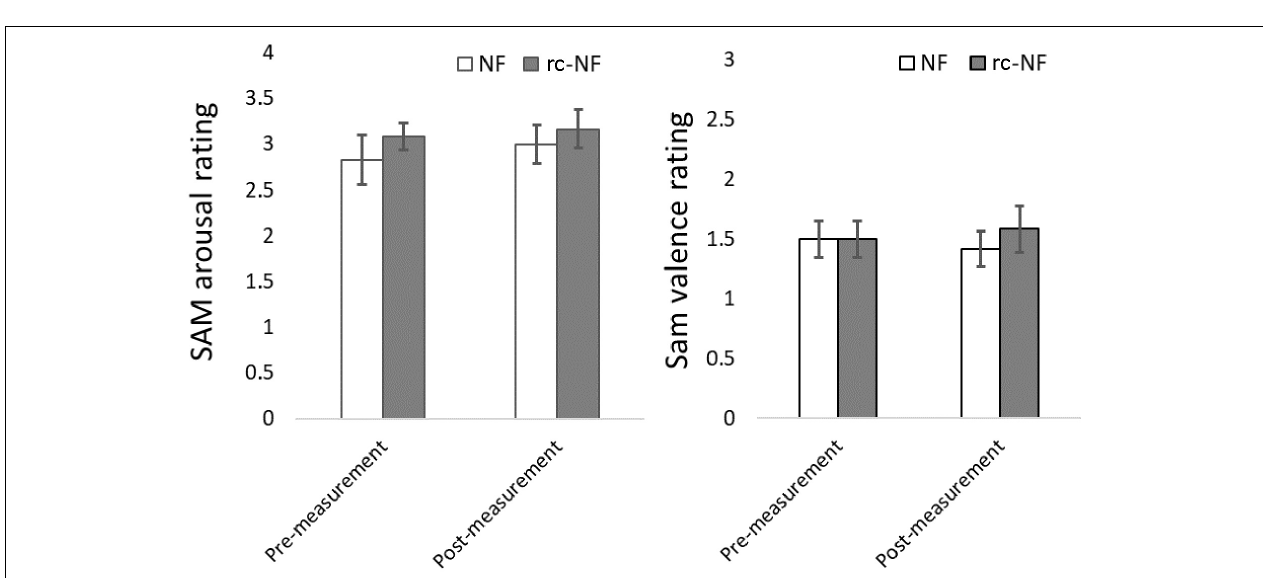
FIGURE 9 | (Left) SAM ratings showing a trend toward more arousal after the VE-NF in both groups but failing significance. (Right) SAM valence ratings did not reveal a difference between premeasurement and postmeasurement. Note that the SAM was simplified to a 4-point Likert scale.